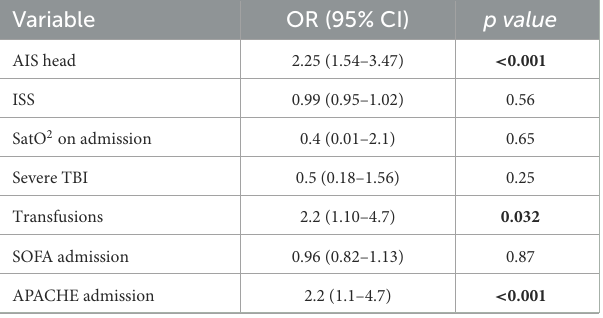
TABLE 4 Multivariate logistic regression analysis for mortality in TBI patients admitted to